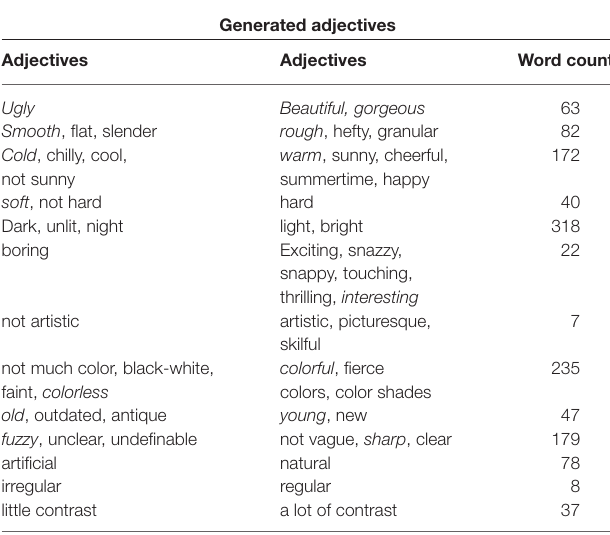
TABLE 1 | Words generated in the adjective generation experiment, grouped together according to